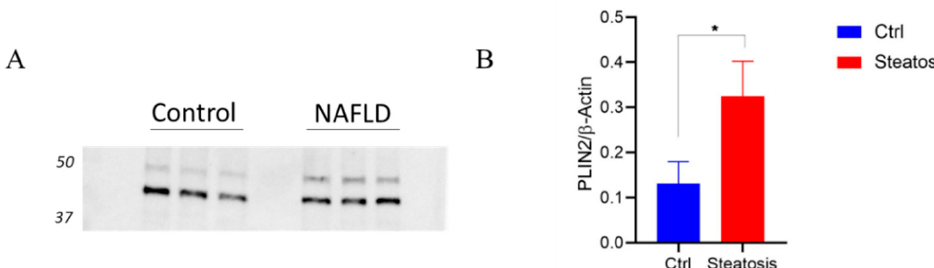
Figure 2. ( A ) Western blot analyses of perilipin-2 (upper band) in NAFLD versus control. ( B ) The signals of beta-actin (lower band) were used to normalize the amounts of loaded protein samples in the densitometric analyses. * indicates a p value < 0.05